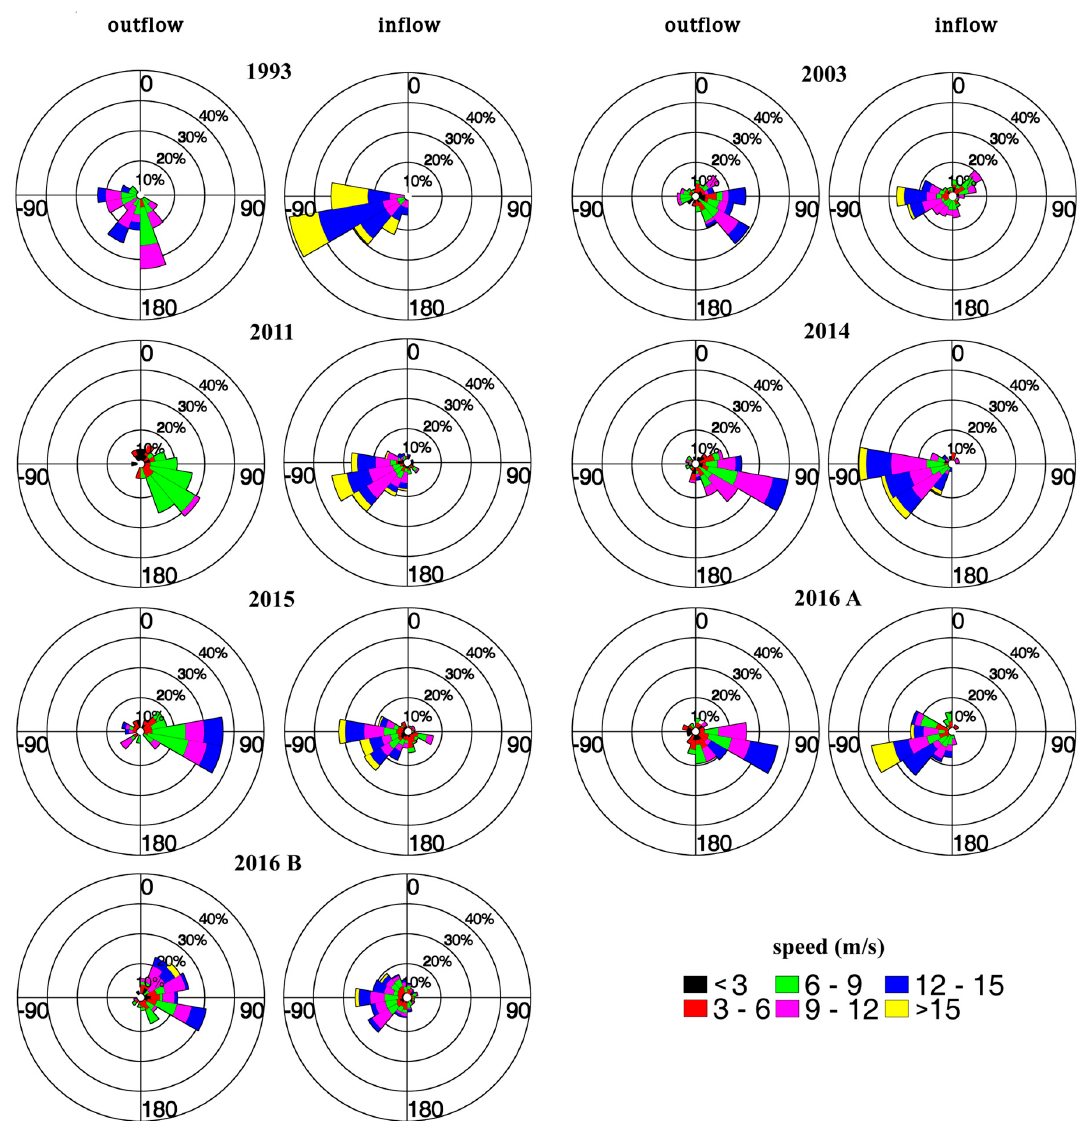
Figure 10. As in Figure 9, but for pixel 2 (Baltic Sea).